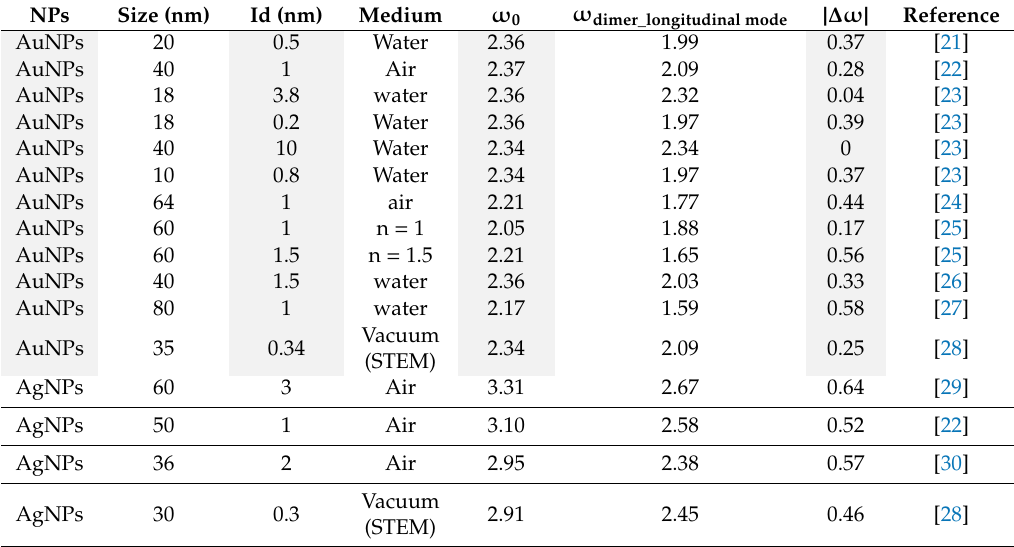
Table 1. Dimer resonance energy from di ff erent published works for Ag and Au NPs, to be used in VM for the investigation of more complex system. In the table ω 0 , w dimer , ∆ ω dim correspond to single nanoparticle resonant energy, dimer resonant energy, and the energy shift, respectively.